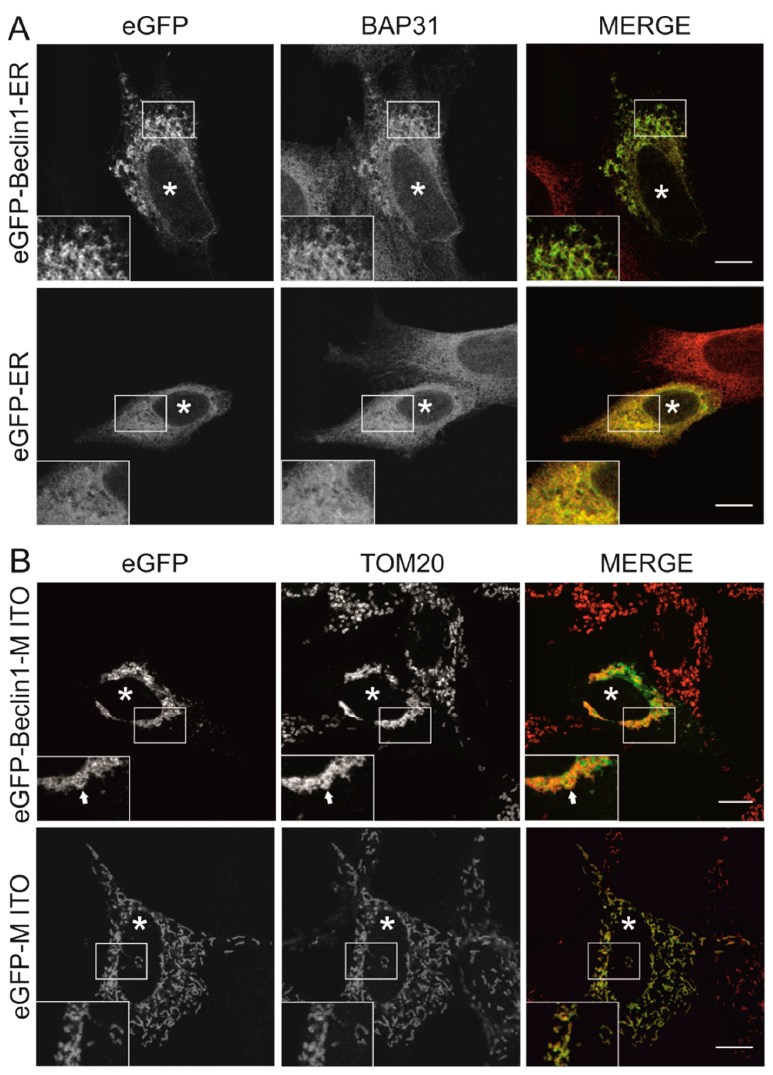
Figure 2. Subcellular localization of eGFP-Beclin 1-ER and eGFP-Beclin 1-MITO, as well as the corresponding targeted control constructs, in mouse embryonic fibroblasts-wild type (MEF-WT). ( A ) MEF-WT cells were transfected with eGFP-Beclin 1-ER or eGFP-ER as indicated, and labelled against endoplasmic reticulum (ER) marker BAP31. ( B ) MEF-WT cells were transfected with eGFP-Beclin 1-